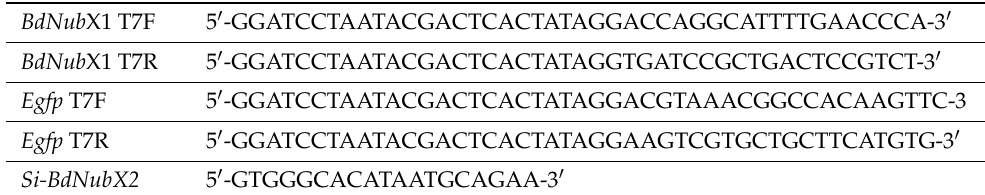
Table 2. The primers used for synthesis of